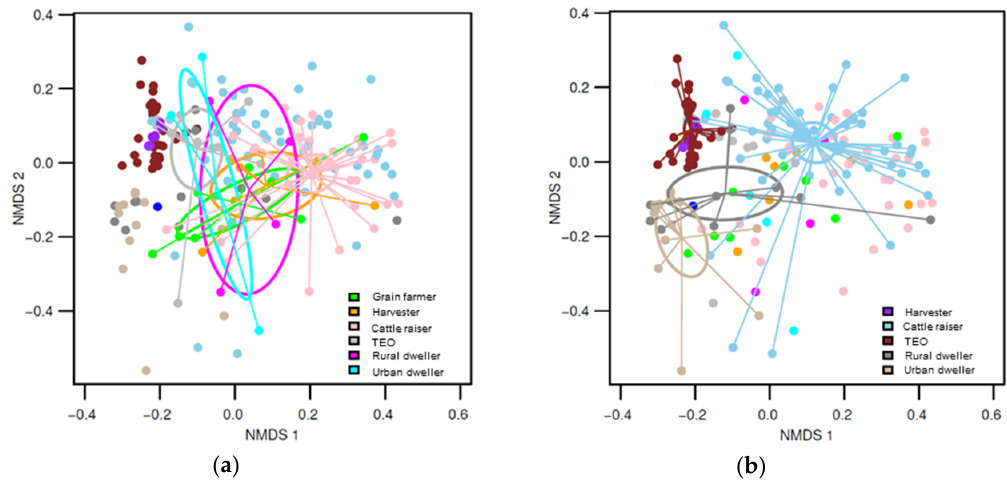
Figure 2. Nonmetric multidimensional scaling graph of fungal communities (stress = 0.1742681), with ordiellipses representing the 95% confidence intervals generated from the standard error, and the communities from each occupation group connected to the centroid by ordispider lines: ( a ) Highlights the communities sampled during the period of low exposure, whereas ( b ) highlights the communities sampled during the period of high exposure to wheat dust.